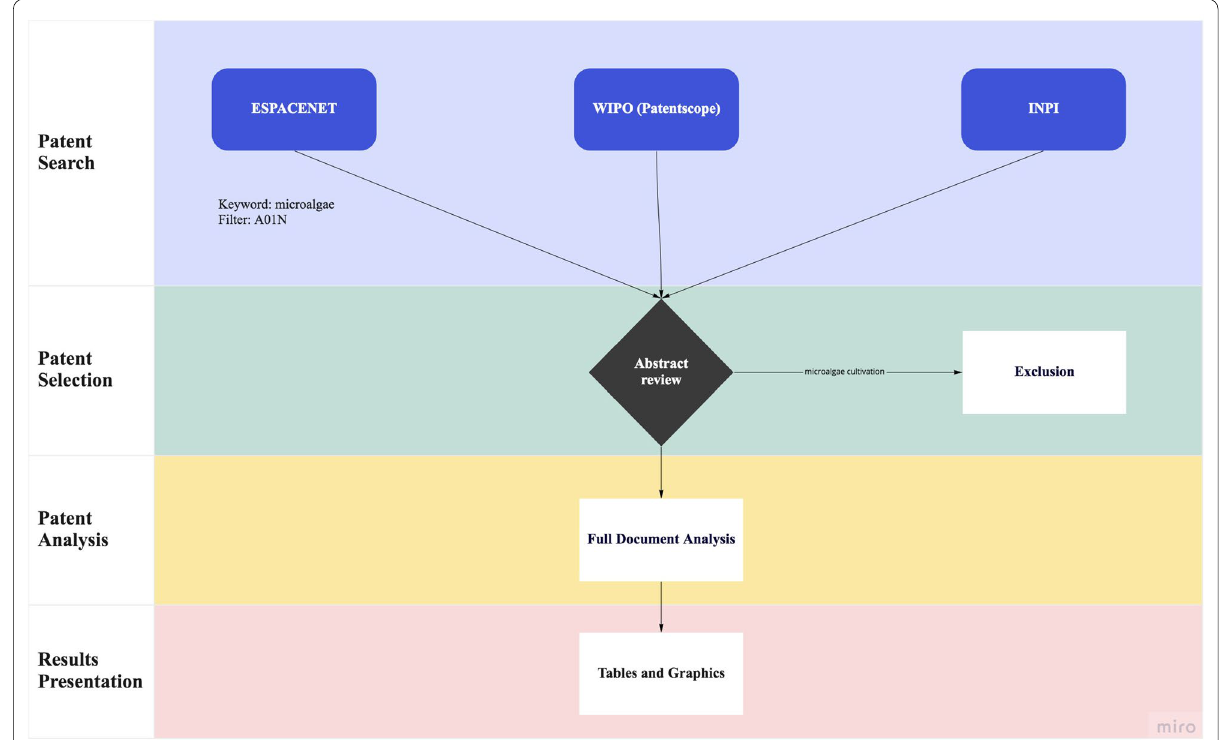
Fig. 1 Diagram with the steps of the patent database search and data analysis